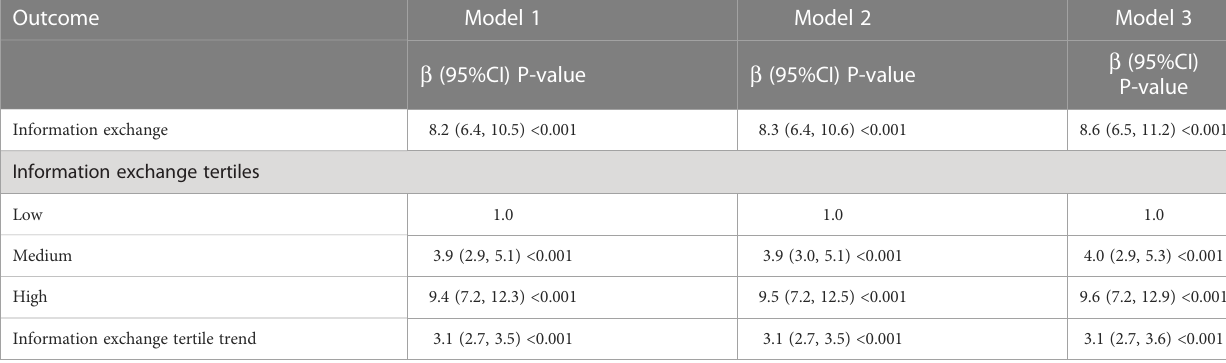
TABLE 3 Multiple regression equation analysis for the relationship between online information exchange and app usage